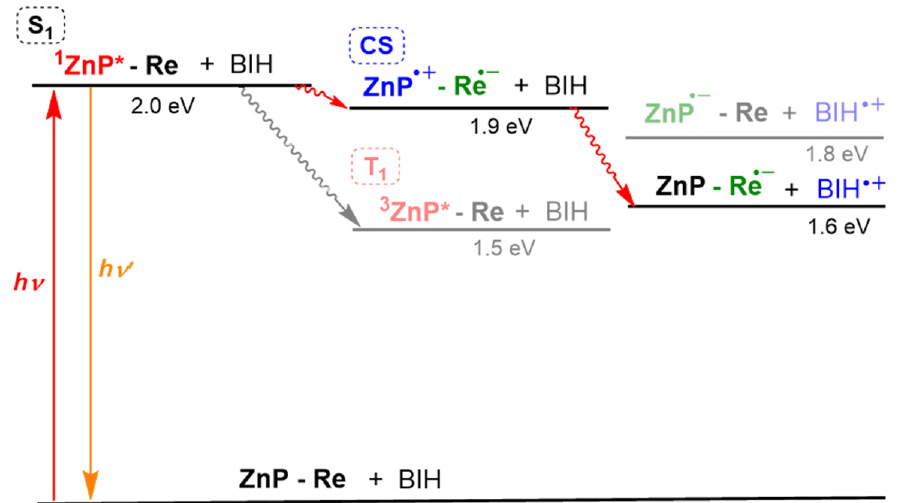
Figure 16. An energy diagram of ReD ′ and BIH in DMA–TEOA. The “ Re ” corresponds to the TEOA-CO 2 adduct, which can change into a more stable reaction intermediate after reduction by the intramolecular electron transfer.